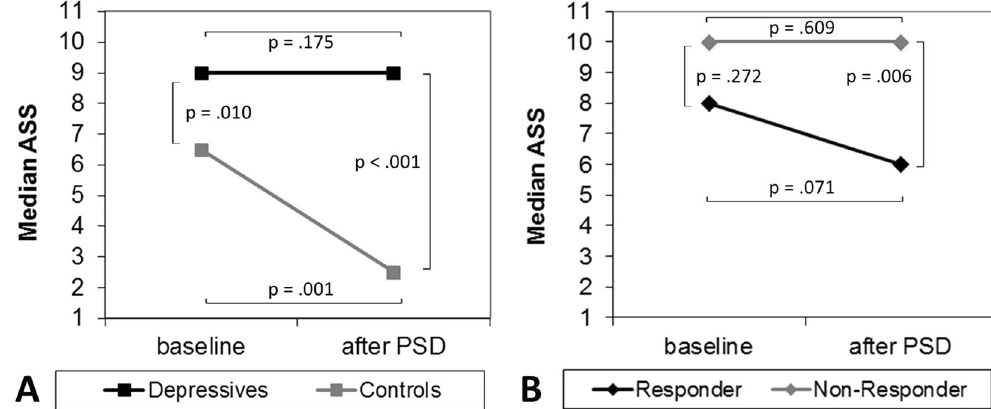
Figure 2. Comparison of Median Arousal Stability Scores (ASS) on day 1 (baseline) and day 2 (after sleep deprivation, PSD) in patients versus controls (part A ) as well as responders versus non-responders (part B ).